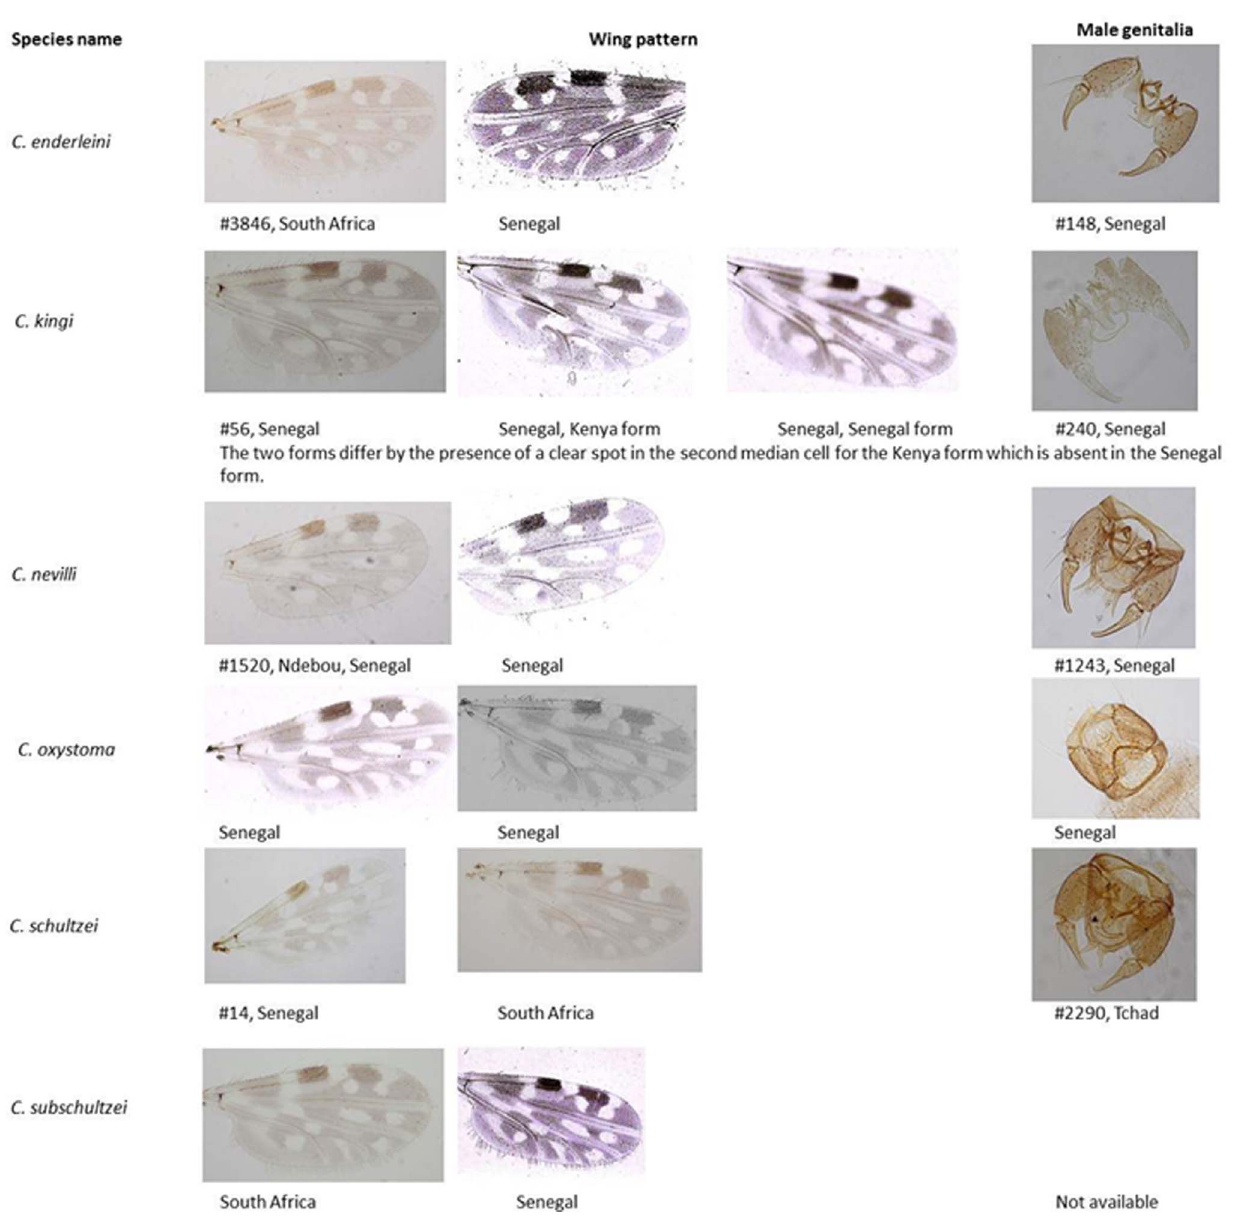
Figure 1. Female wing pattern and male genitalia of the Schultzei species group collected in Senegal (samples from the study and Cornet’s collection) and South Africa. The slide reference number refers to the Cornet collection reference numbers